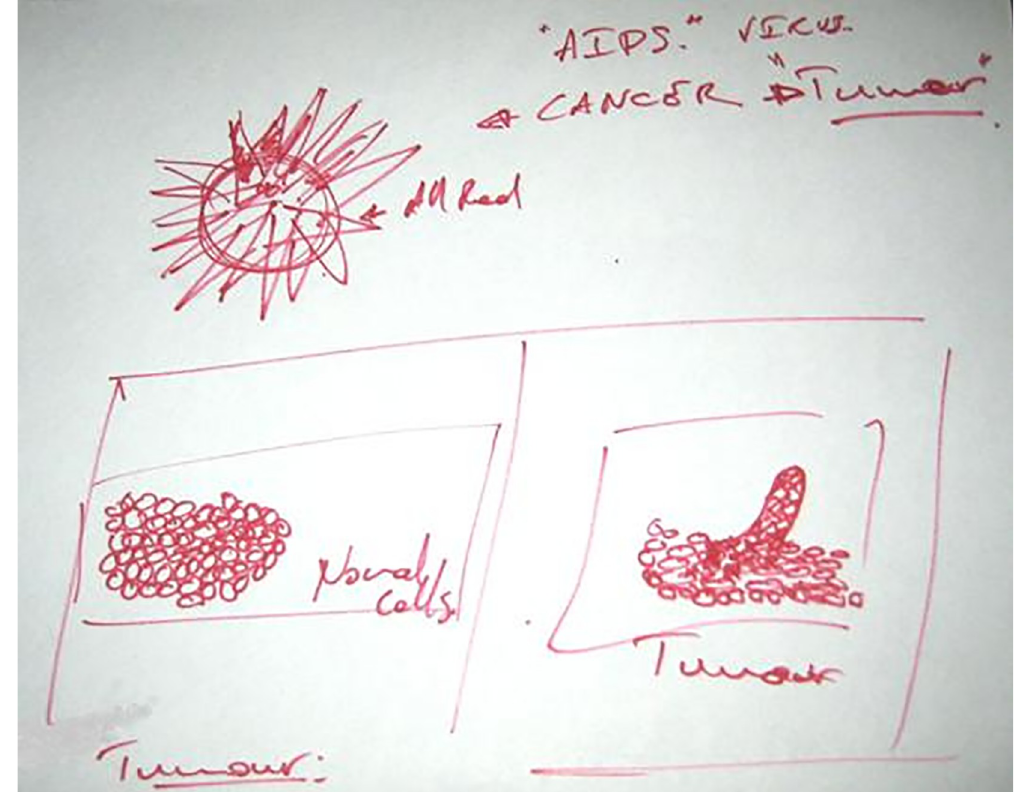
Fig 4. Jean-Claude, T1, Tumour in the oral cavity.